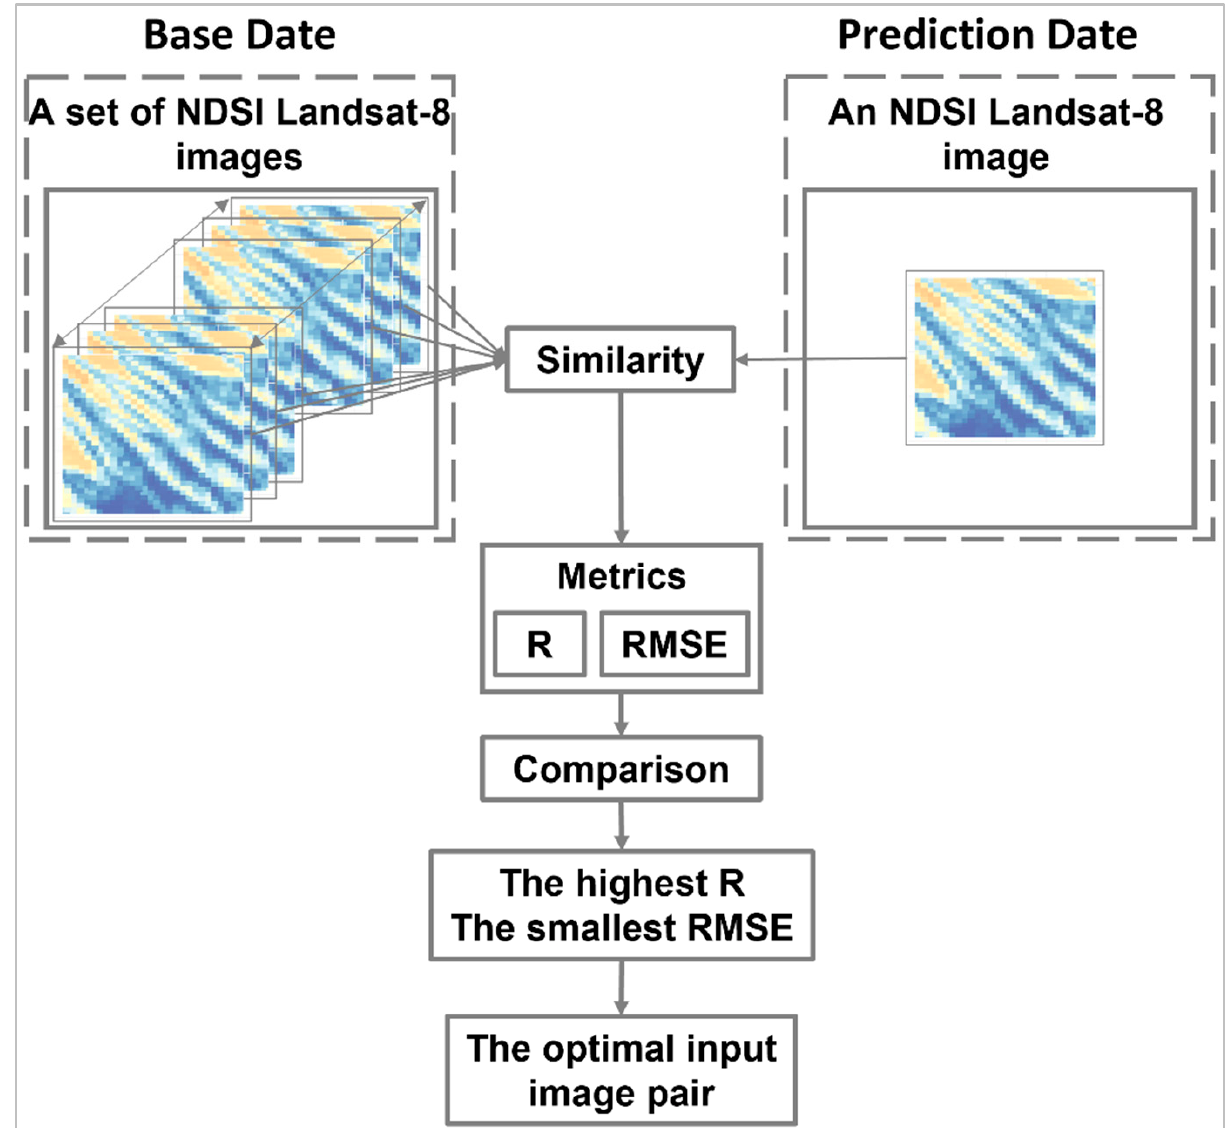
Figure 4. Graphical representation illustrating the “similarity” and “consistency” criteria for the choice of the input image pair.